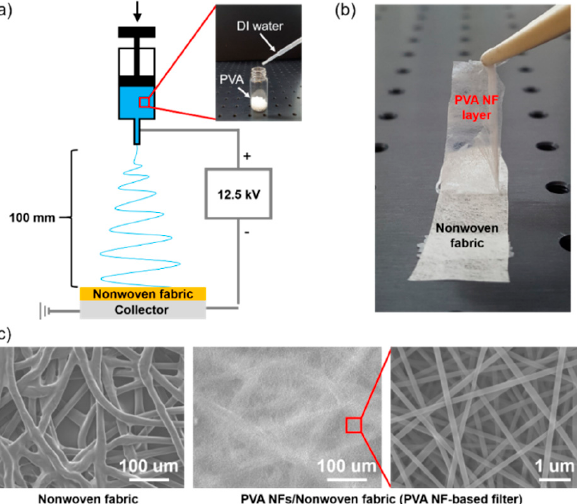
Figure 1. ( a ) Schematic of electrospinning; ( b ) photograph of a poly(vinyl alcohol) nanofiber (PVA NF) − based filter fabricated by electrospinning on a nonwoven fabric substrate; ( c ) surface FE-SEM images of the nonwoven fabric substrate and PVA NF − based filter.